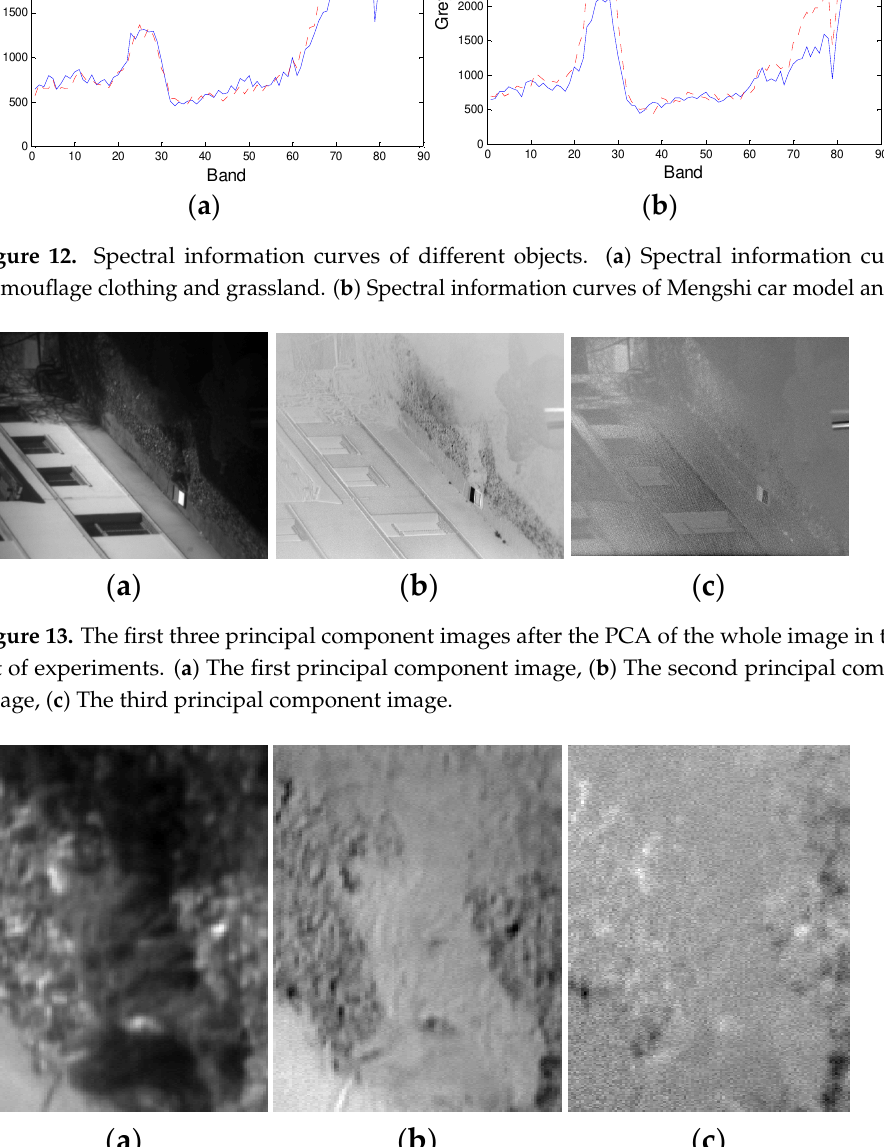
Figure 12. Spectral information curves of different objects. ( a ) Spectral information curves of Cam- ouflage clothing and grassland. ( b ) Spectral information curves of Mengshi car model and bush.